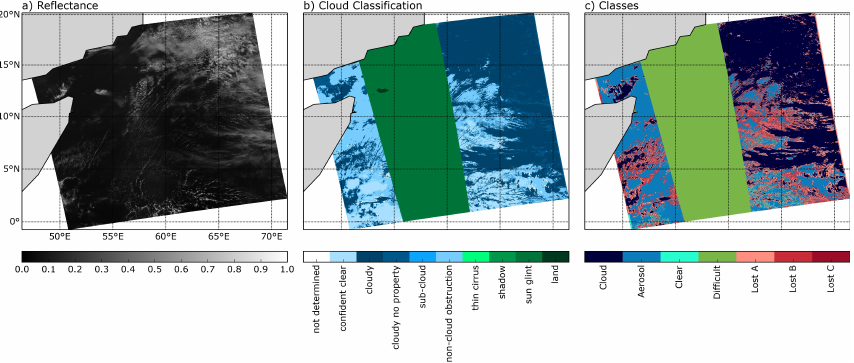
Figure 2. Example scene for the classification procedure with ( a ) reflectance; ( b ) cloud classification (combining MYD35 and MYD06); and ( c ) the resulting classes for 19 August 2007 at 9:30